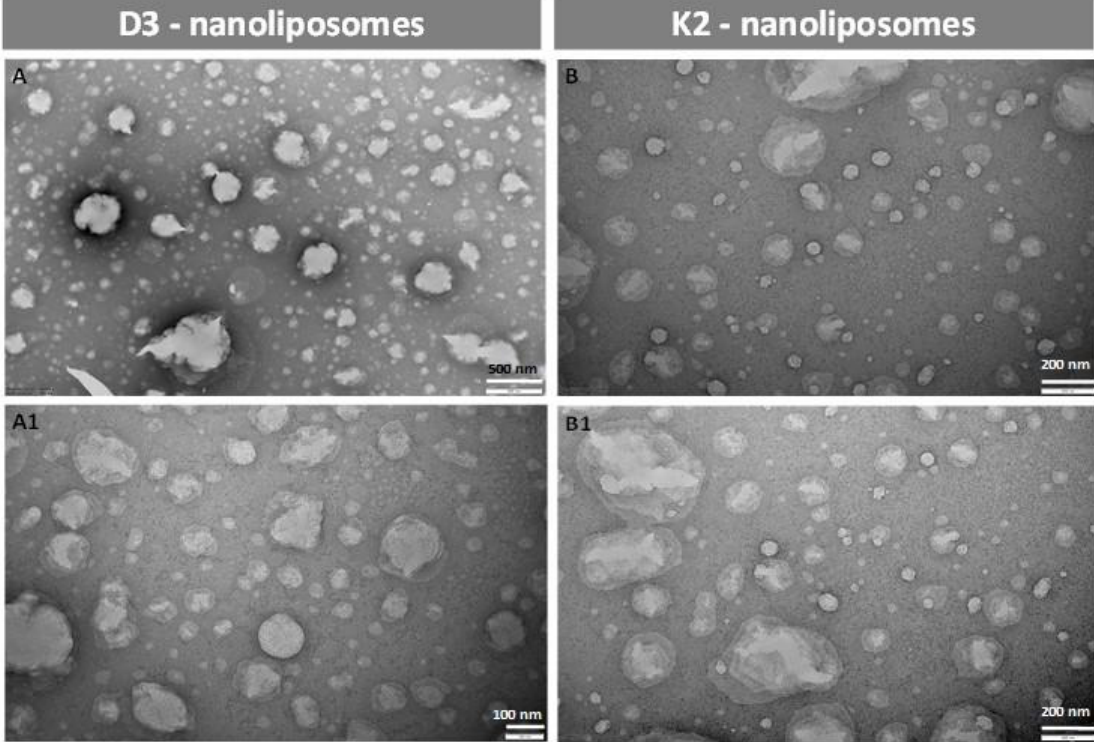
Figure 2. Transmission electron microscopy (TEM) images of D3 and K2 nanoliposomes fresh samples (A and B, respectively) and after 1 month of storage (A1 and B1, respectively).